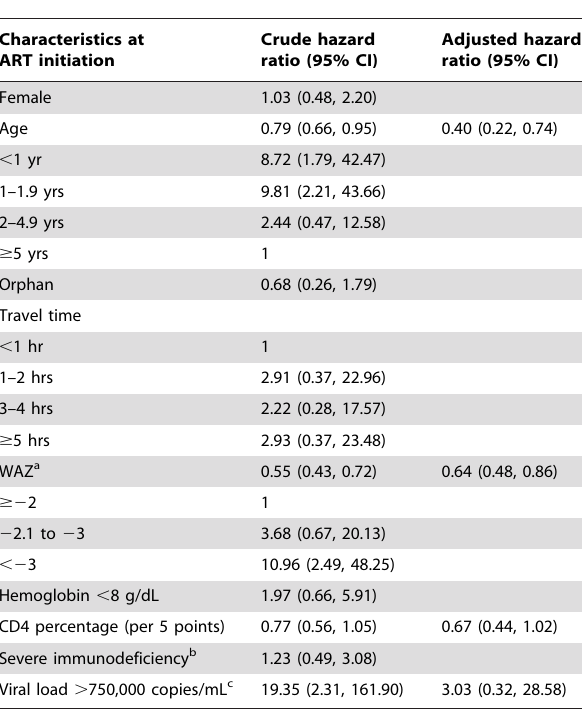
Table 2. Risk factors for mortality after initiation of antiretroviral